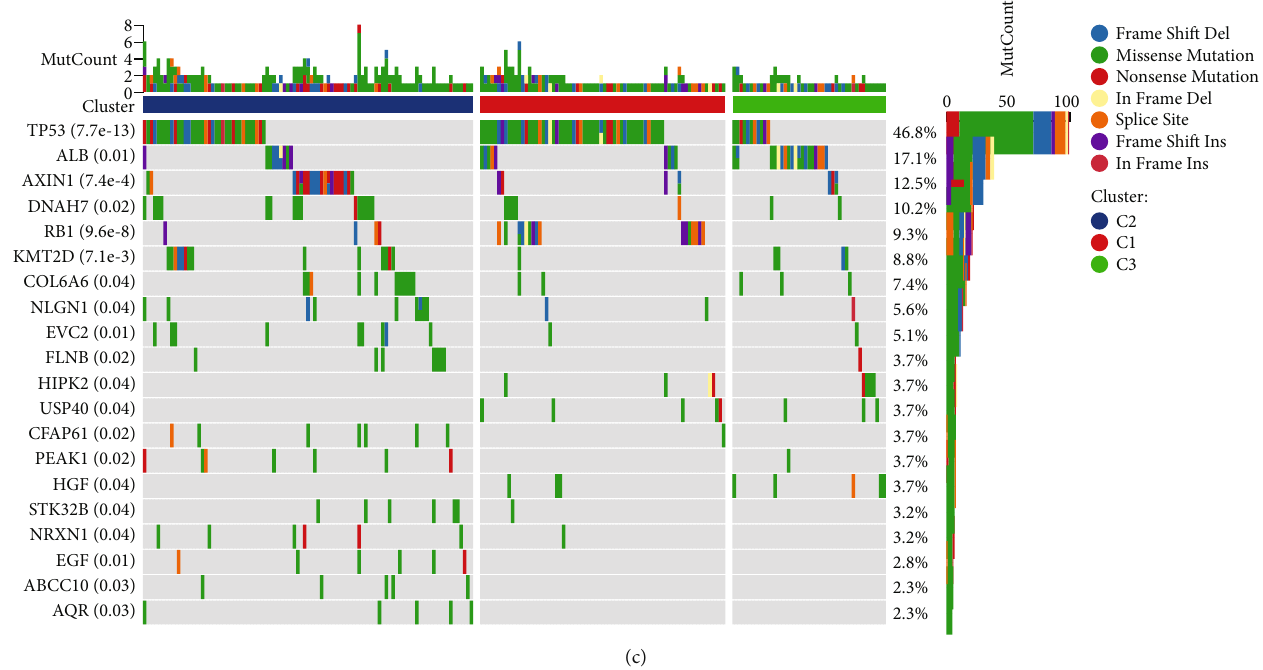
Figure 2: Genomic mutation pro fi les of three clusters. (a) Comparisons of the homologous recombination defects, aneuploidy score, altered fraction, number of segments, and tumor mutation burden in three clusters from TCGA. (b) Determination of immune molecular di ff erences in three clusters. (c) Determination of cellular mutation di ff erences in three clusters. *P < 0.05; **P < 0.01; ***P <